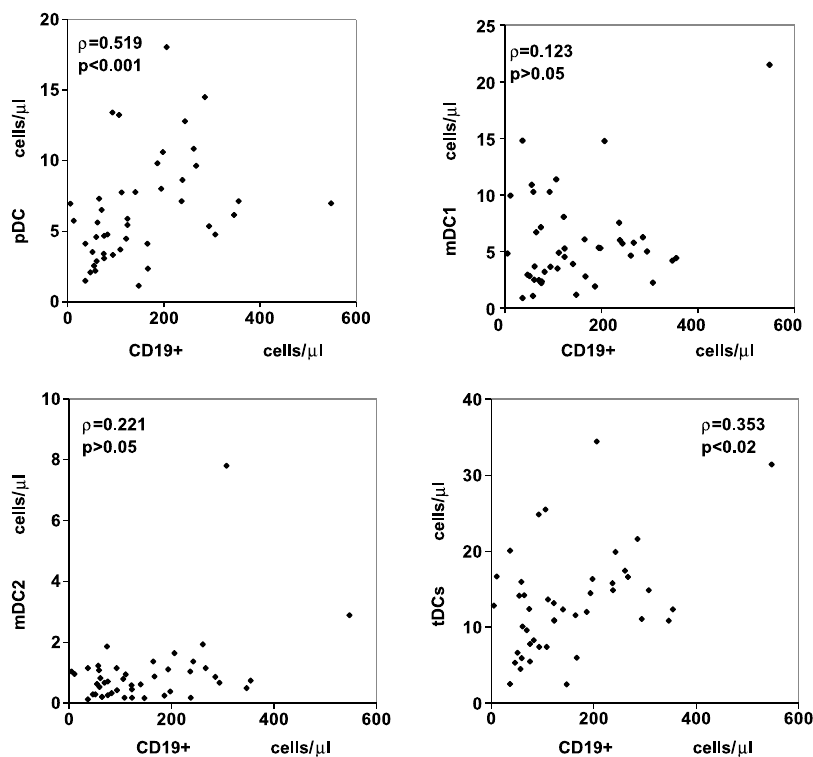
FIG. 4. Correlations between the number of B CD19 (cid:2) cells with total dendritic cells (tDC) and their pDC and myeloid (mDC1 and mDC2) subpopulations in the peripheral blood of SLE